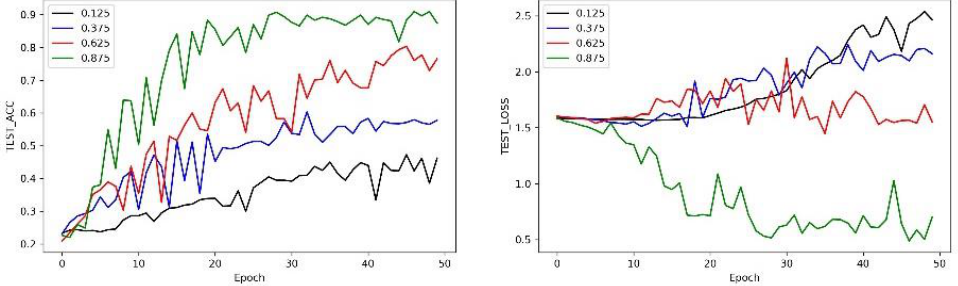
Figure 17. Results of TM3 between different objects.